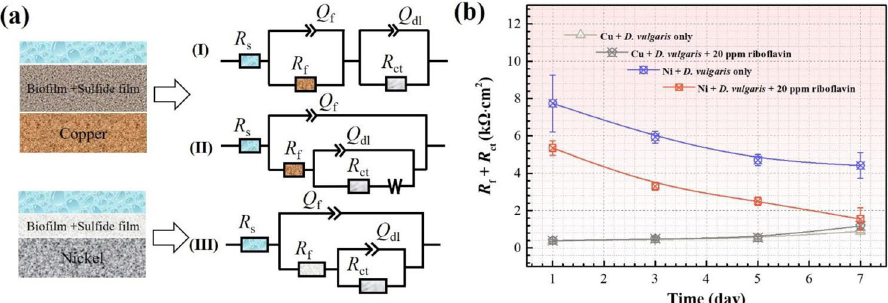
Fig. 12 Equivalent circuit diagram of EIS fi tting. a Equivalent circuit models for EIS fi tting, b Variation of R f + R ct of Cu and Ni coupons during the 7-d incubation in the D. vulgaris media without and with ribo fl avin. (Error bars stand for the standard deviations from at least three independent coupons).